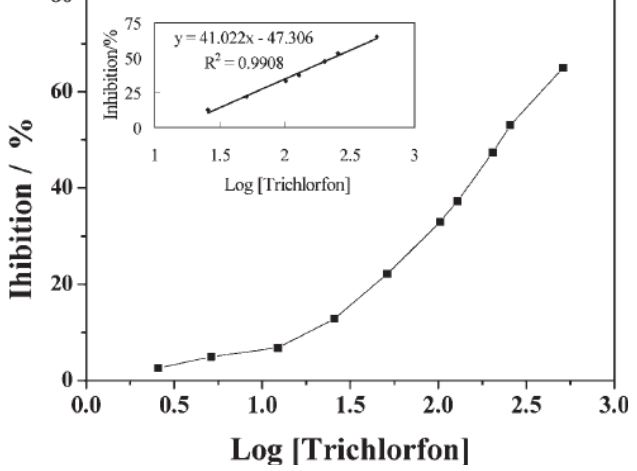
Figure 10. Inhibition plot of the AChE/ QCdS-PVP /GCE biosensor by trichlorfon after 5 min incubation. Measurement conditions: PBS 0.1 M, pH 7.0; E = +0.6 mV (vs. SCE); 2.0 x 10 -5 M acetylthiocholine iodide (reproduced with permission from Li et al.